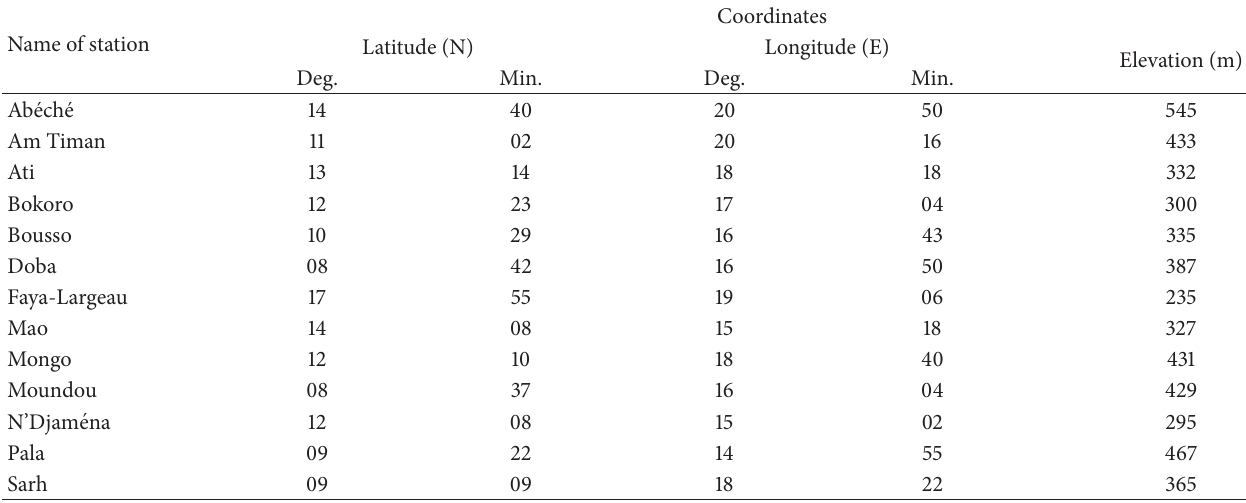
Table 1: Physical features of the meteorological